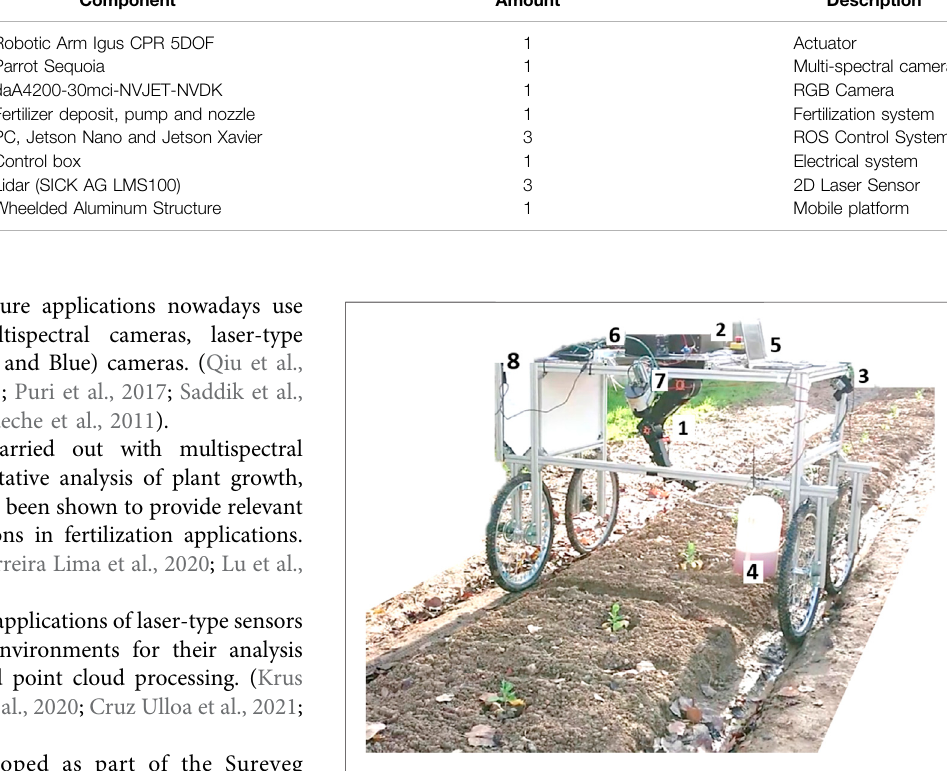
FIGURE 1 | Mobile robotic platform in a cabbage